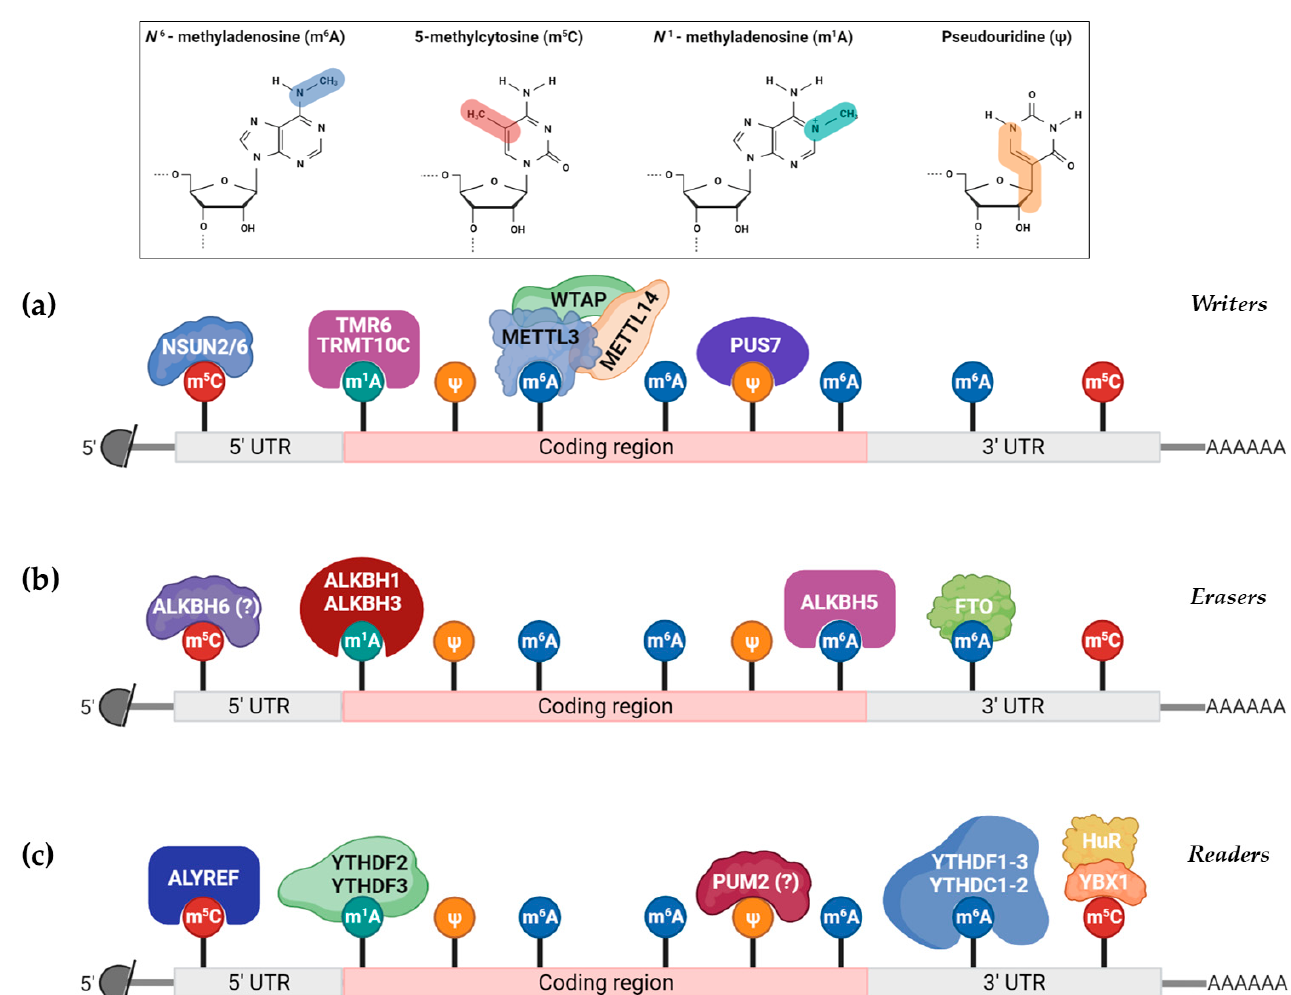
Figure 2. Common eukaryotic mRNA modifications that have been identified. The abundancy of each modification is strictly regulated by ( a ) “writers”, proteins that incorporate the specific modification in specific mRNA sites, ( b ) “erasers”, which catalyze the removal of a specific modification from the mRNA and ( c ) “readers”, which interact with specific modifications to regulate a wide spectrum of cellular processes.